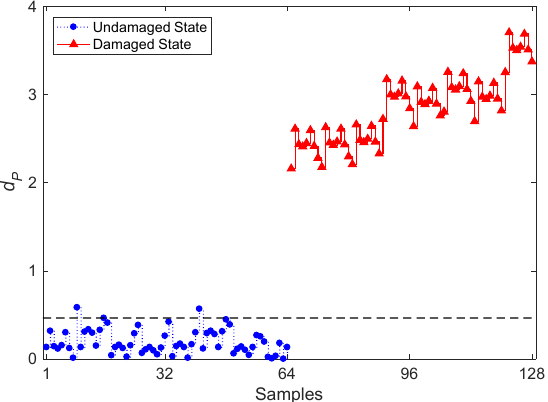
Figure 5. Evolution of the distance value d P based on the proposed partition-based Kullback–Leibler divergence-nearest neighbor (PKLD-NN) method and on the CBFE algorithm, using the ARMA(33,33) model.